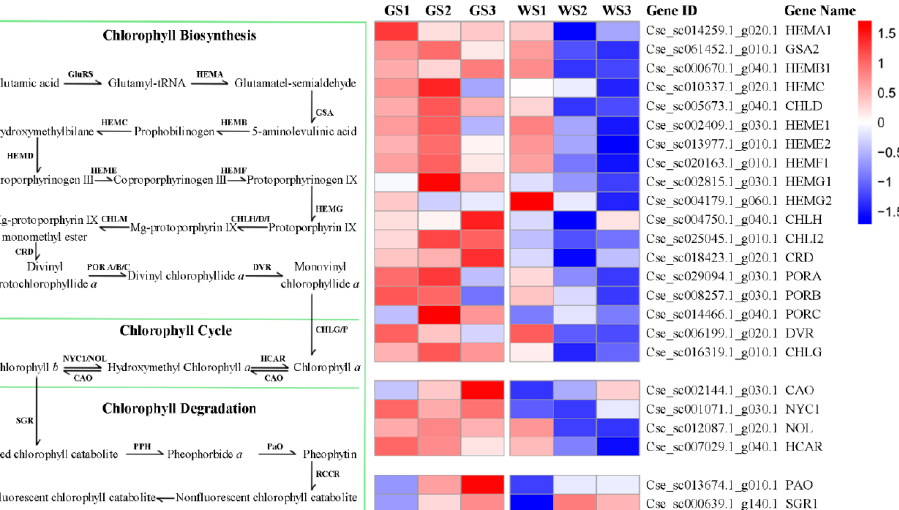
Table 2. Enrichment of key KEGG pathways among DEGs.